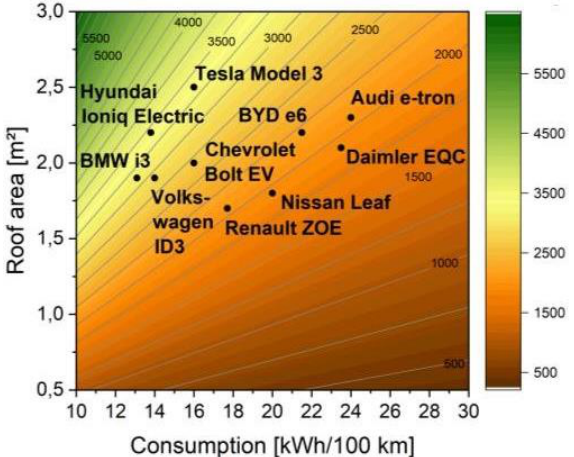
Fig. 10. Potential solar range for different electric vehicles depending on available horizontal roof area and consumption [44]